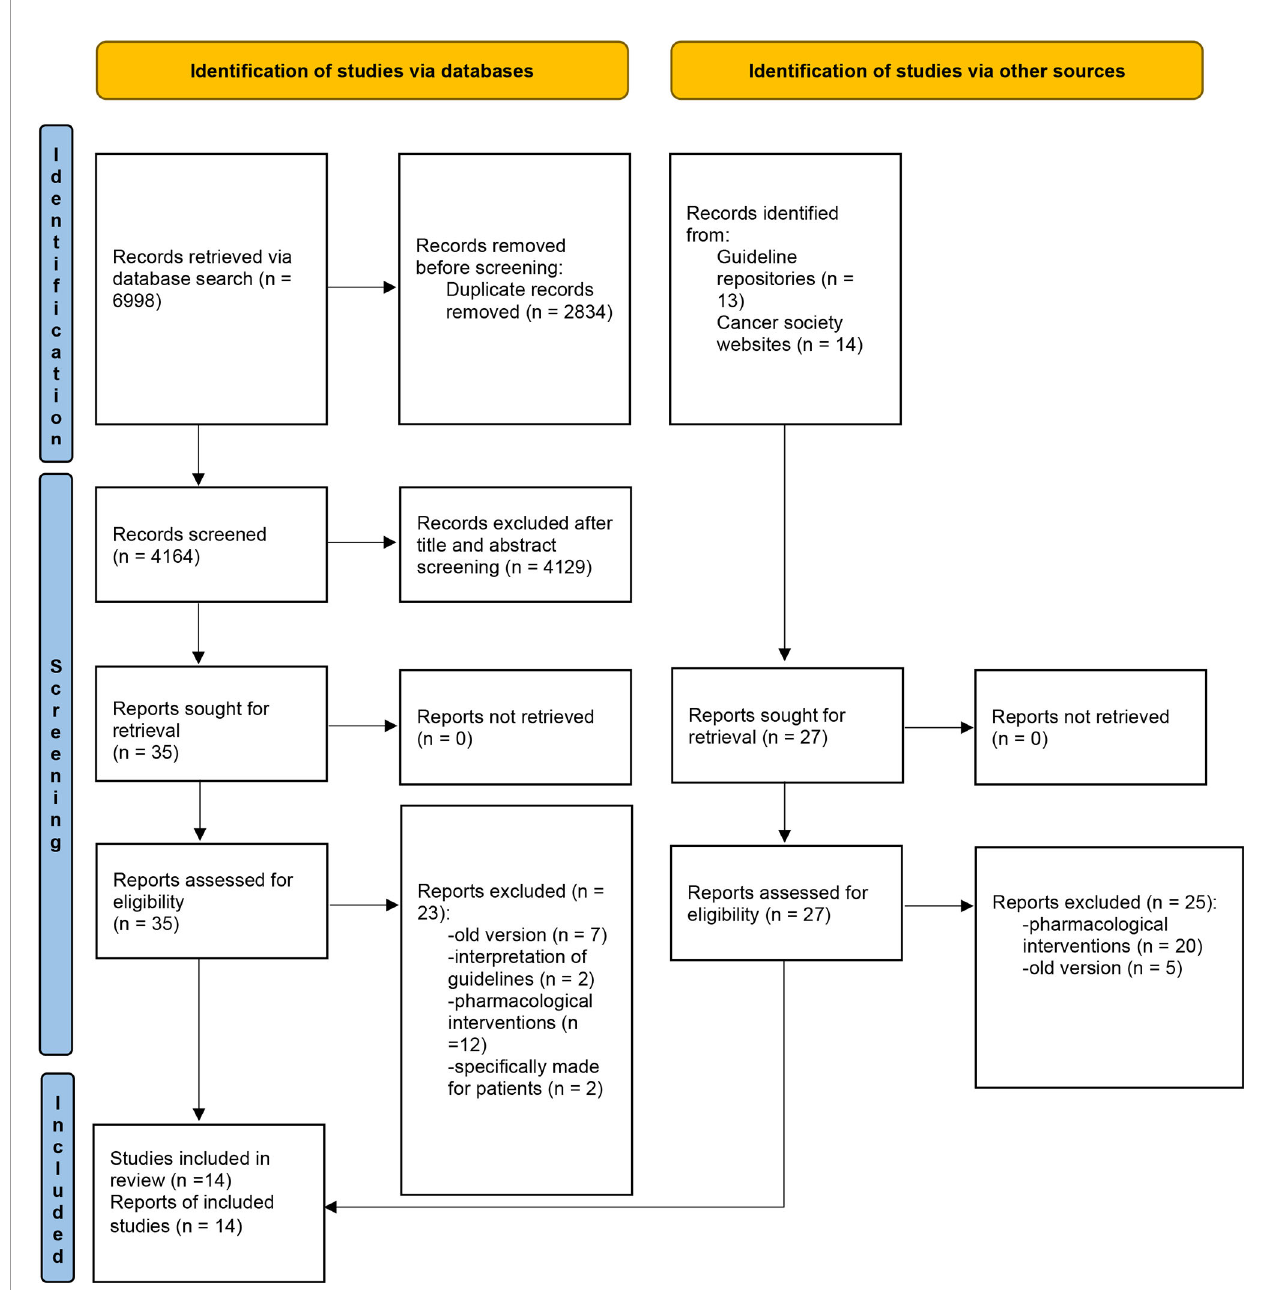
FIGURE 1 | PRISMA fl ow diagram of study selection. Adapted from: Page MJ, McKenzie JE, Bossuyt PM, Boutron I, Hoffmann TC, Mulrow CD, et al. The PRISMA 2020 statement: an updated guideline for reporting systematic reviews. BMJ